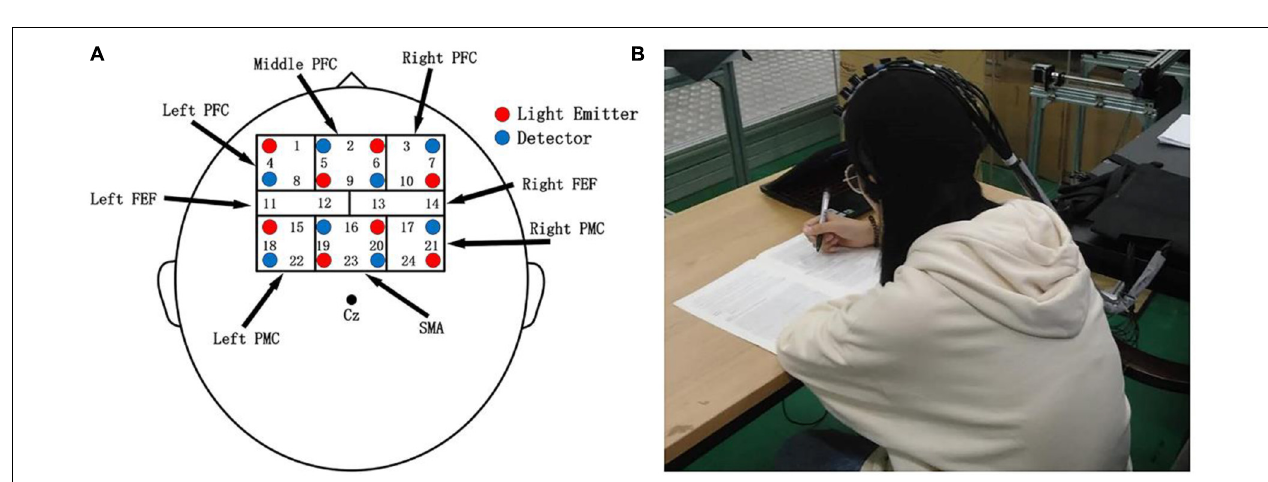
FIGURE 2 | A schematic diagram of the n-back experiment. Participants were required to respond to the same consecutive stimulus and press the button as quickly as possible. The inter-stimulus interval (ISI) of the stimulus is 3 s.